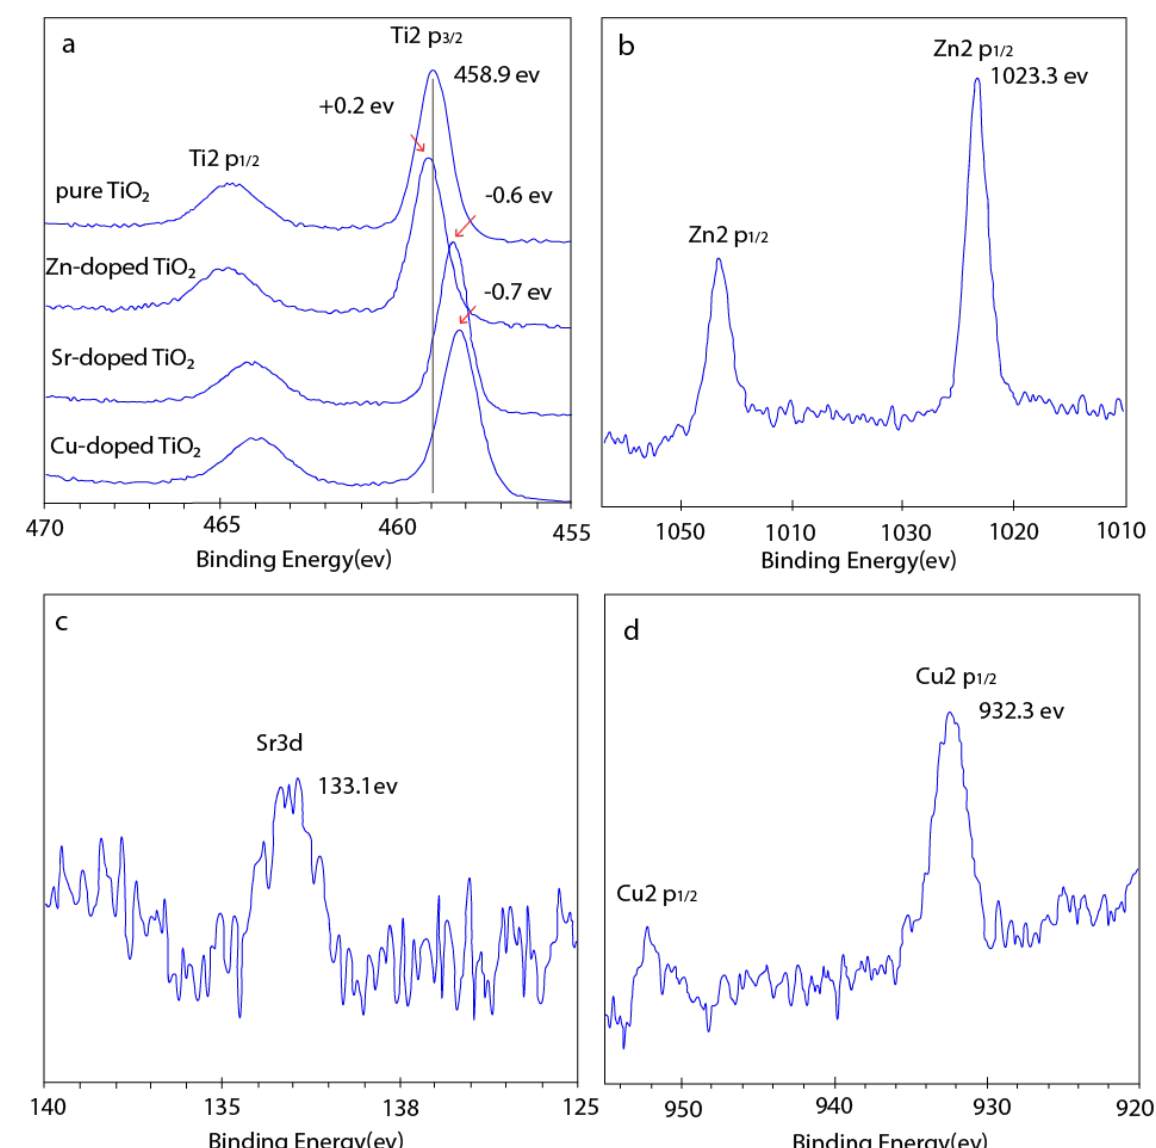
Figure 3. High-resolution XPS spectra of pure and doped TiO 2 nanotube arrays after annealing. ( a ) Ti 2p in pure and doped TiO 2 nanotube samples, ( b ) Zn 2p spectrum of Zn-doped TiO 2 , ( c ) Sr 3d spectrum of Sr-doped TiO 2 , and ( d ) Cu 2p spectrum of Cu-doped TiO 2 nanotube